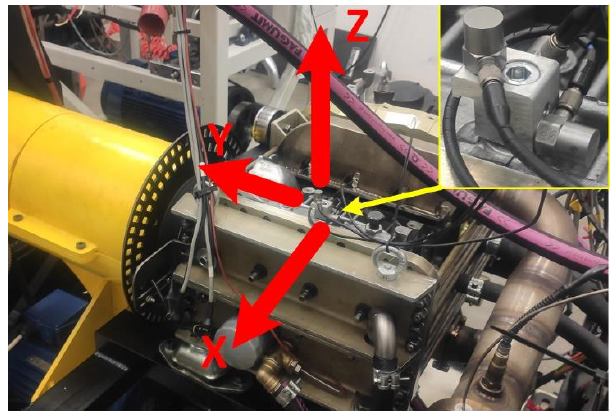
Fig. 3. Location of accelerometers on the test unit block (X-axis of cylin- ders, Y-axis of crankshaft, Y-vertical axis)